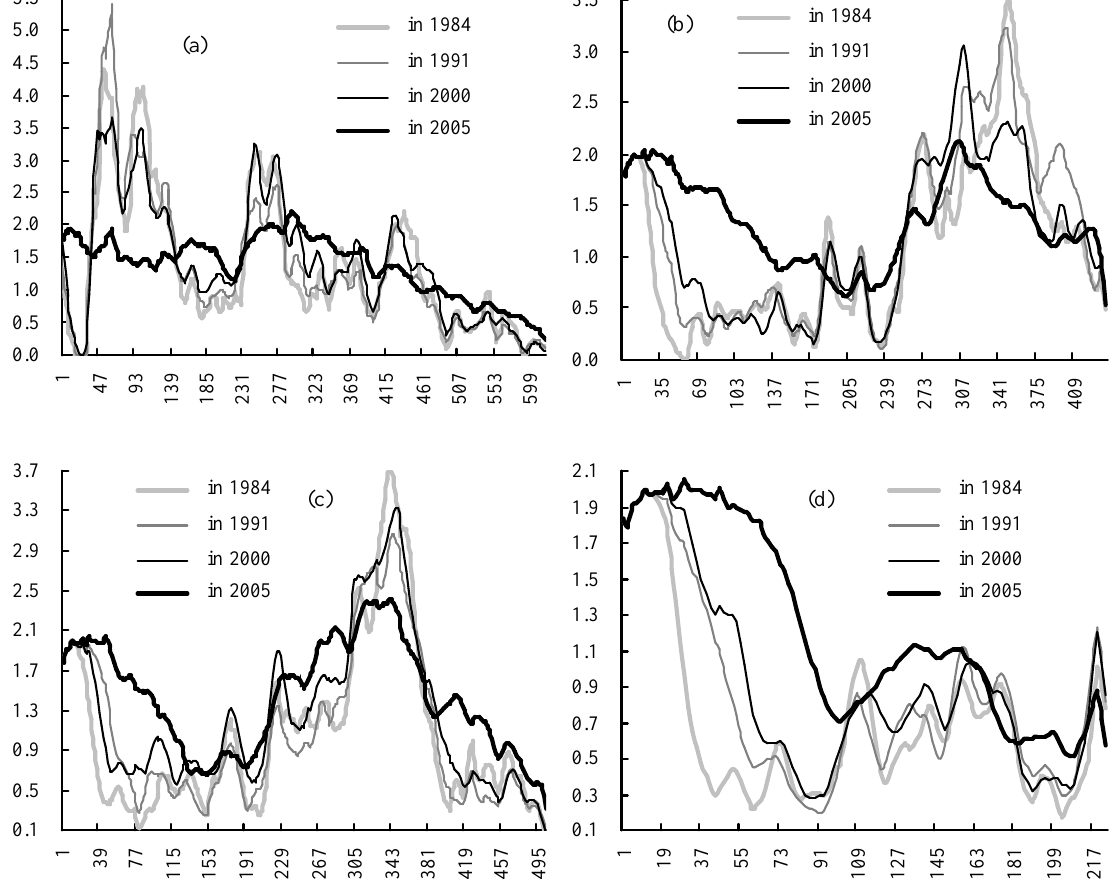
Figure 5. Scaling behavior in the five years, respectively, centered at: (a) baricenter,